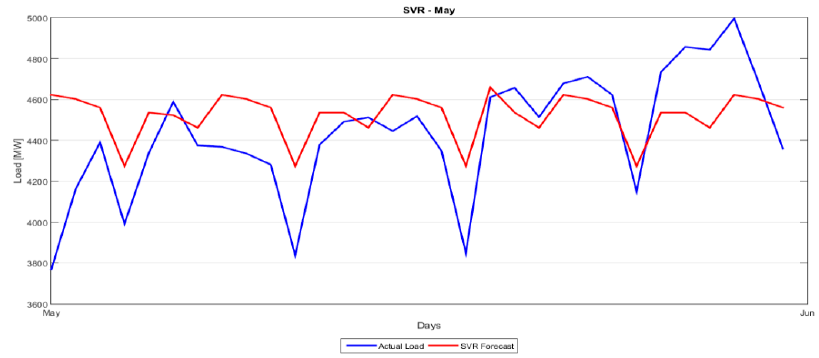
Figure 25. SVR forecast for May 2014. Energies 2016 , 9 , 635